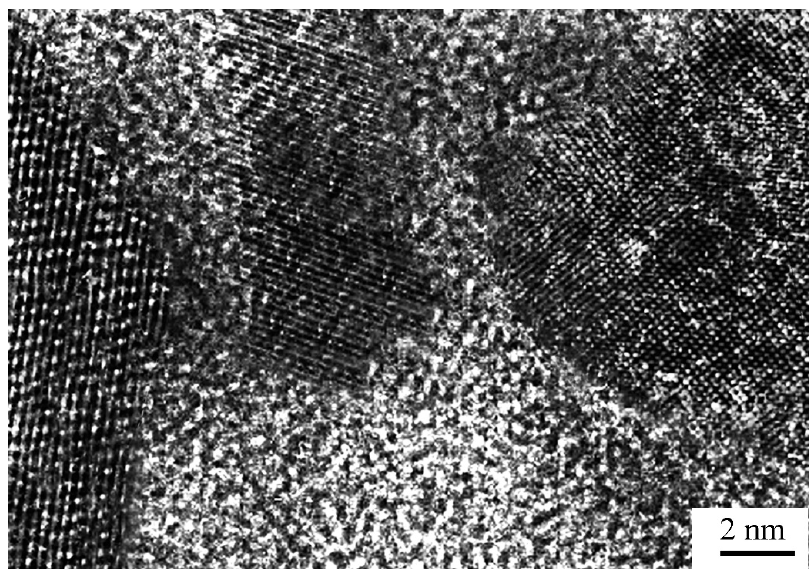
Figure 1. ( a ) Bright ‐ field and ( b ) dark ‐ field electron microscope images of the microstructure of (Ni70Mo30)90B10 sample after annealing at 873 K for 144 h.